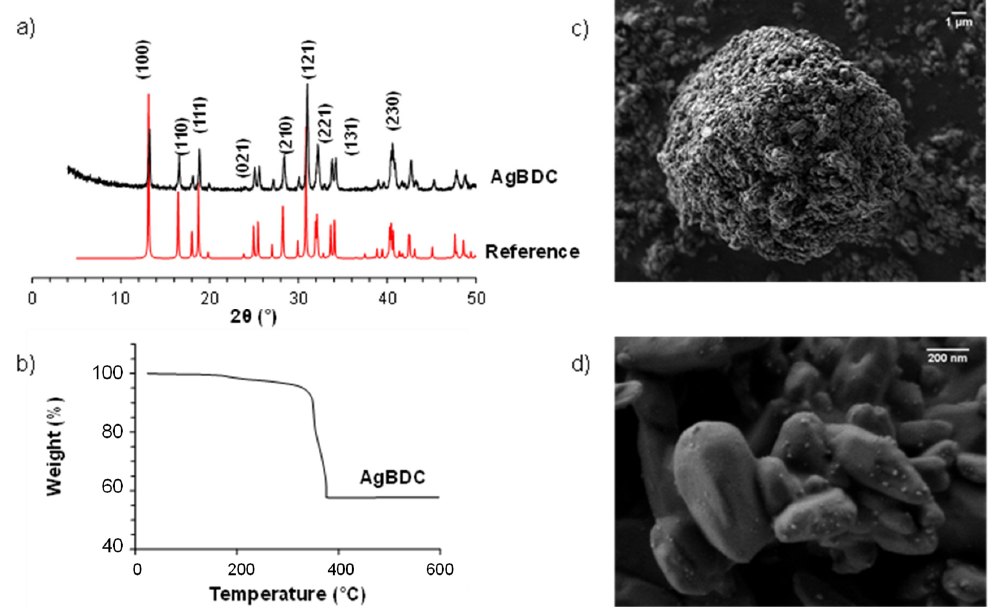
Figure 1. Characterization of synthesized AgBDC MOF. ( a ) XRPD patterns of as-synthesized AgBDC (up) compared to the simulated reference (down). ( b ) TGA and ( c,d ) SEM micrographs of AgBDC samples. Scale bar: 1 µm ( c ) and 200 nm ( d ).